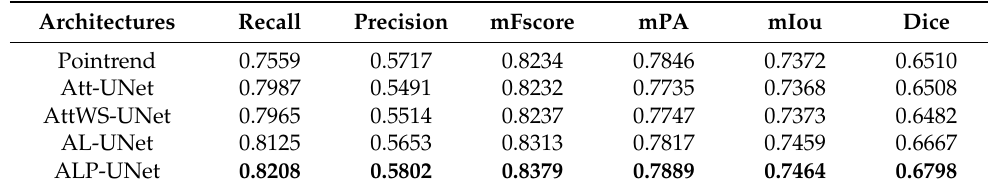
Table 2. Comparison results of ablation experiments on different modules.